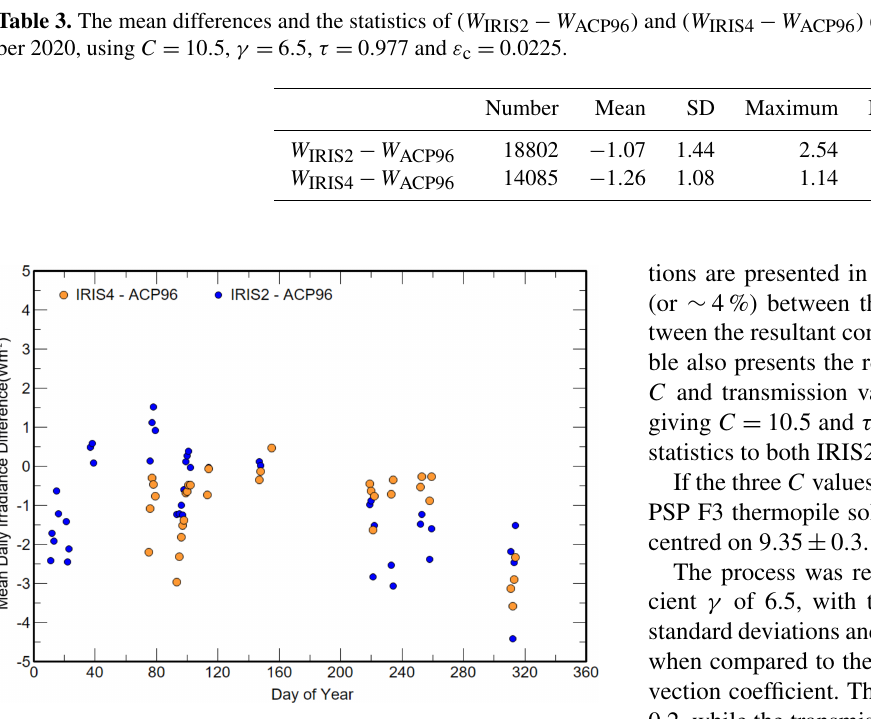
Figure 3. The daily mean differences and the statistics of ( W IRIS2 − W ACP96 ) and ( W IRIS4 − W ACP96 ) (Wm − 2 ) from January to Novem- ber 2020, using C = 10 . 5, γ = 6 . 5, τ = 0 . 977 and ε c = 0 . 0225.